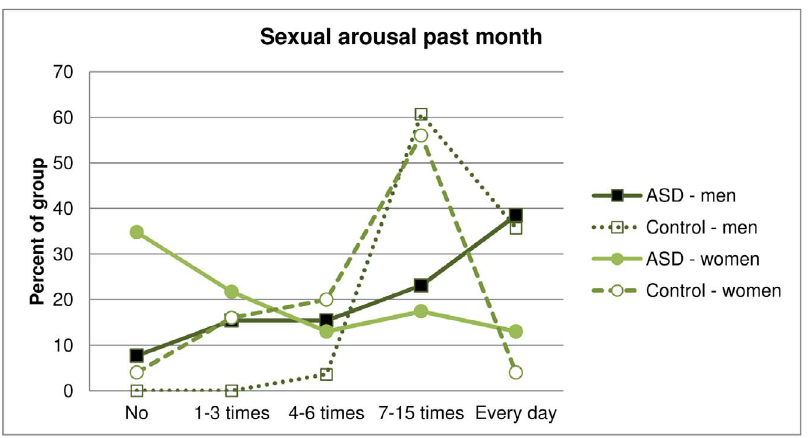
Figure 2. Frequencies of sexual arousal in men and women with and without autism spectrum disorder.